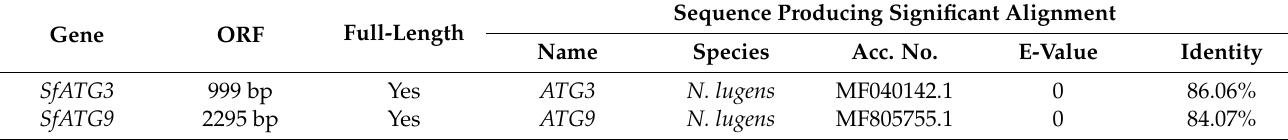
Table 2. Sequence information and alignment of SfATG3 and SfATG9 .